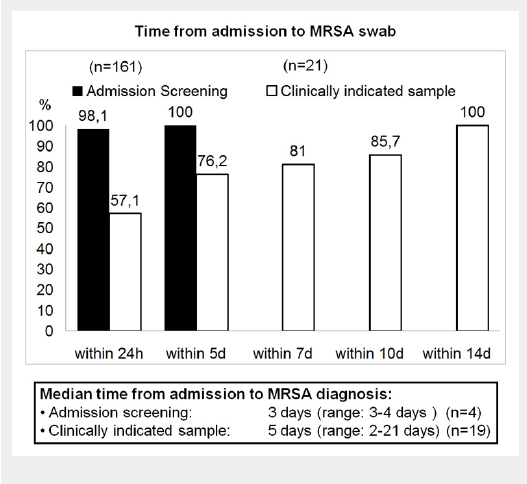
Time from admission to MRSA swab and MRSA